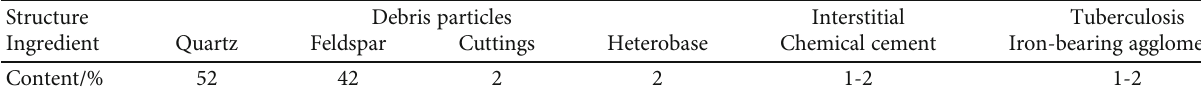
Table 1: Results of mineral and argillaceous cement composition.